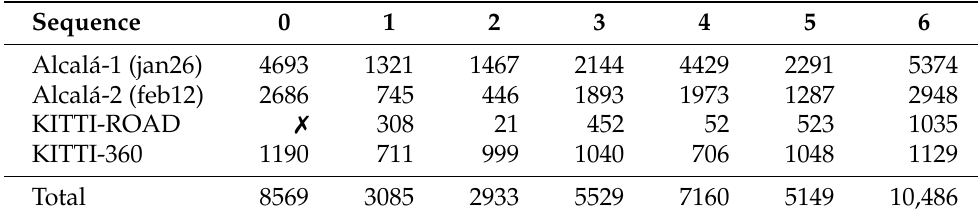
Table 1. Intersections frames per-class, all datasets.